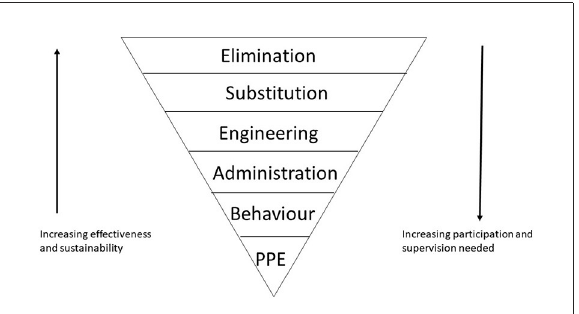
FIGURE1 The hierarchy of control [modified from Franklin and Scarr